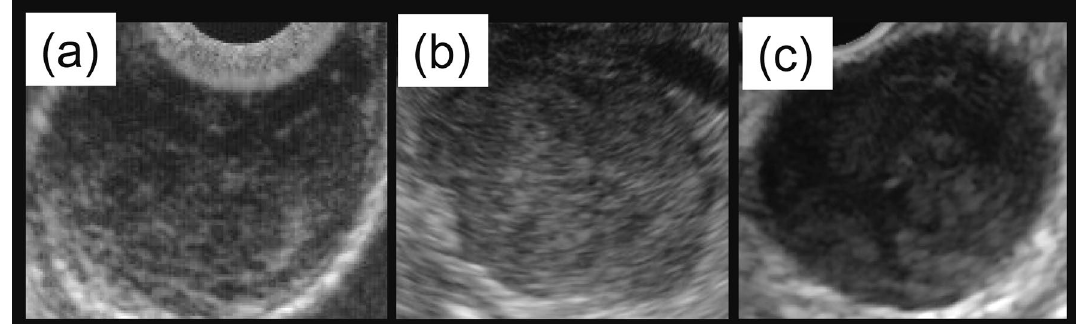
Figure 3. Representative EUS images of each lesion. Representative EUS images evaluated by EUS-AI were shown. ( a ) Esophageal leiomyoma, ( b ) duodenal GIST, ( c ) colonic